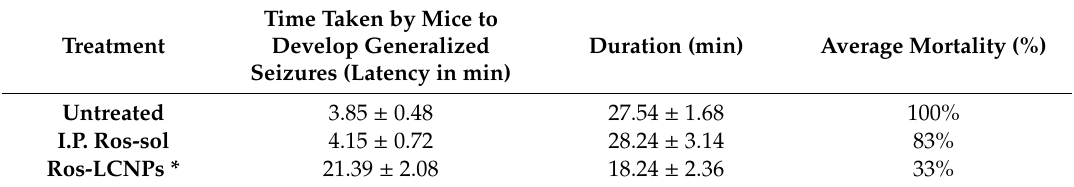
Table 3. E ff ect of Ros-LCNPs on status epilepticus; data are expressed as mean ± SEM; n = 6 in each group, ANOVA followed by Tukey’s